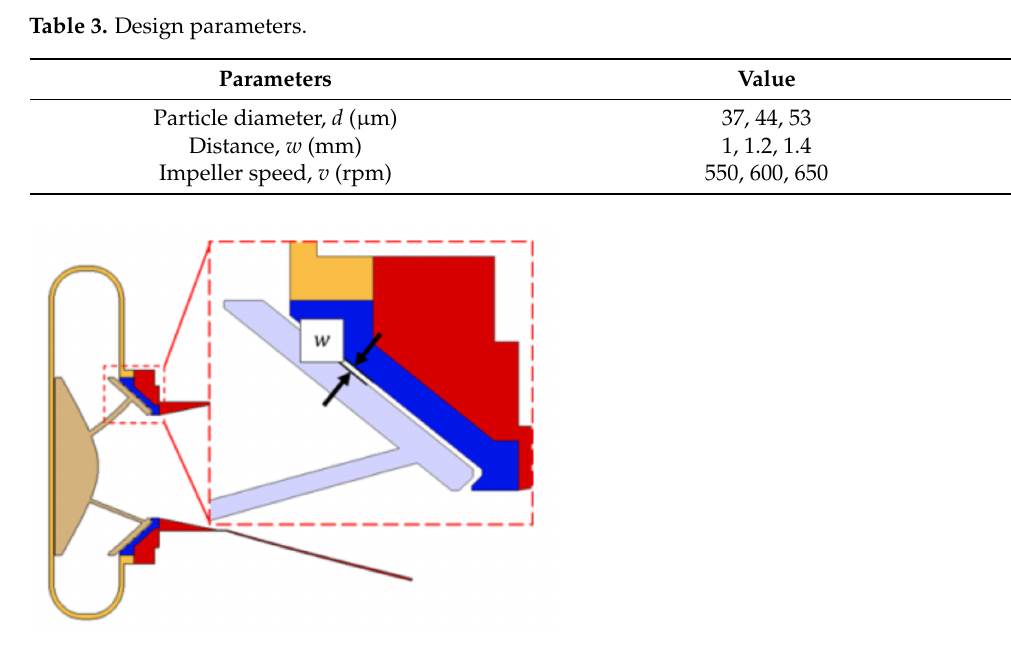
Figure 4. Gap between the impeller and the throat